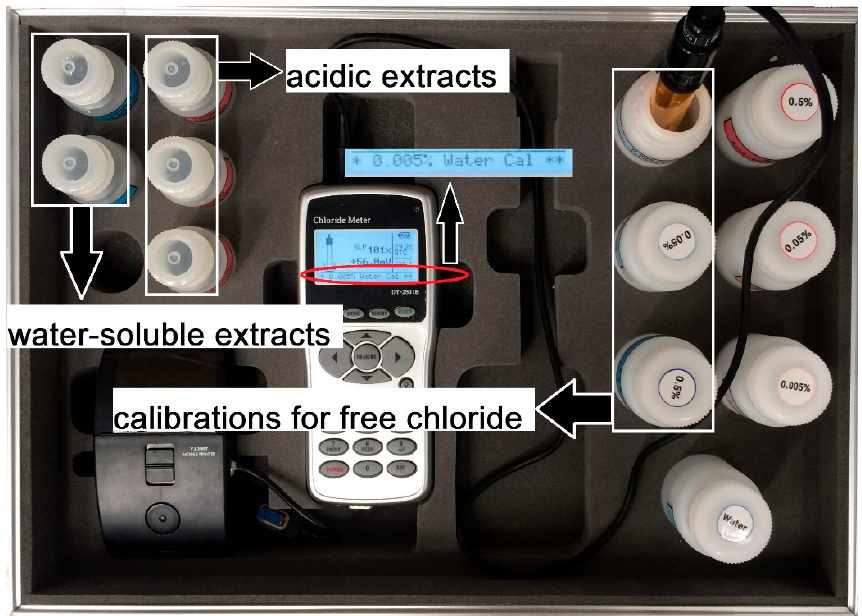
Figure 7. Determination of free chloride content.